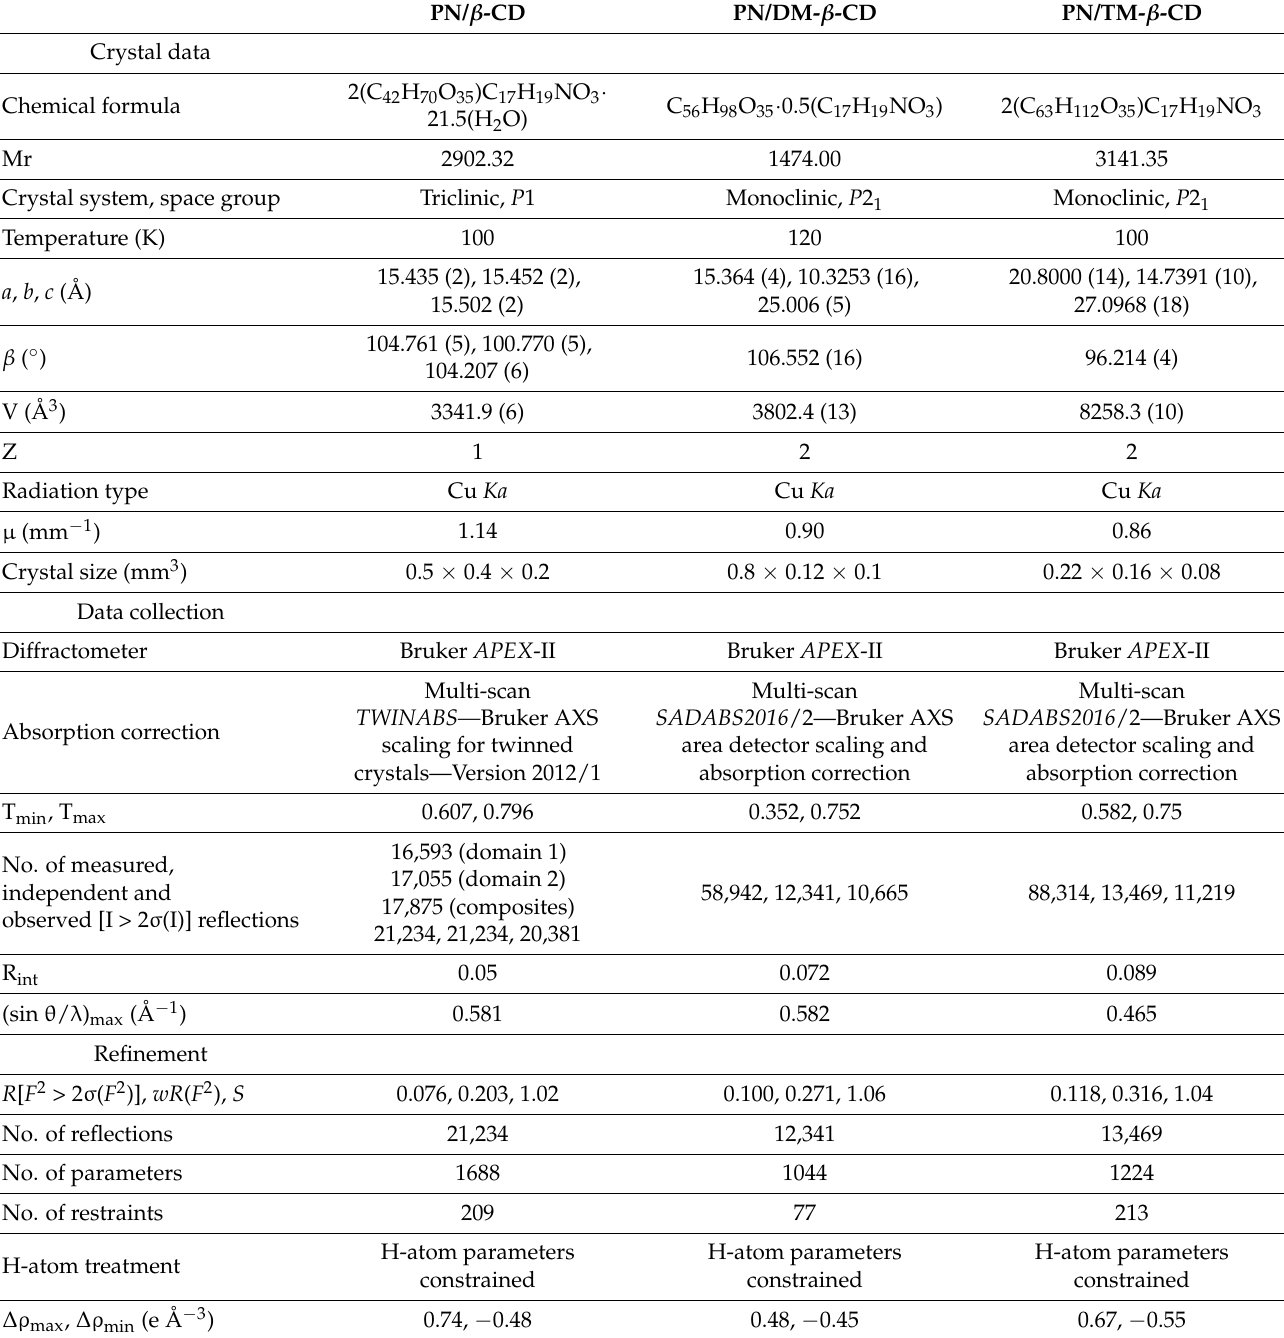
Table 1. Experimental details, crystal data and refinement